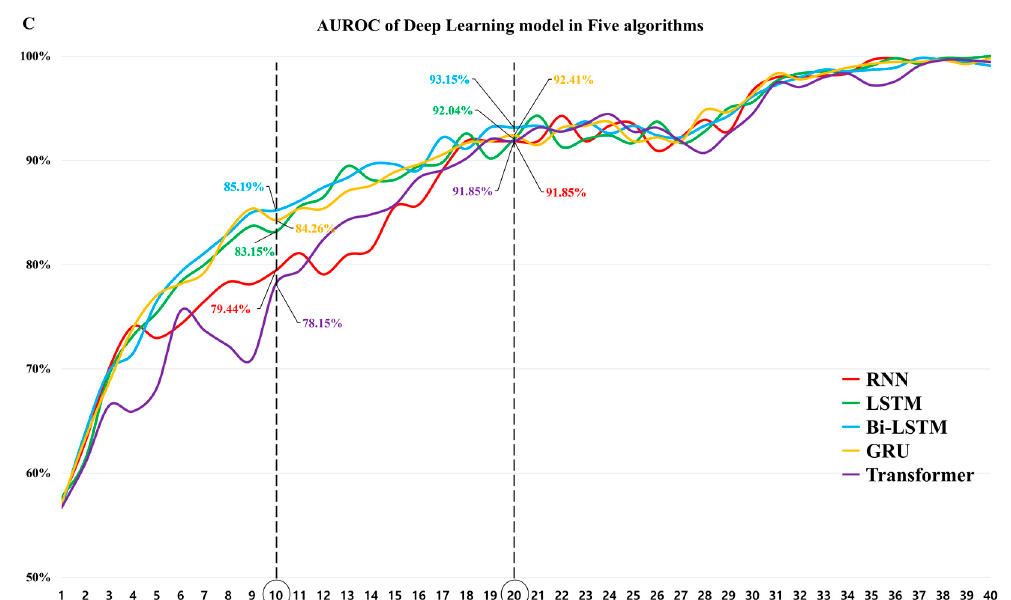
Figure 4. Diagnostic performance of DL models in five different algorithms using the test dataset. ( A ) Sensitivity of DL model in five algorithms. ( B ) Specificity of DL model in five algorithms. ( C ) AUROC of DL model in five algorithms. RNN: recurrent neural network; LSTM: long short-term memory; GRU: gated recurrent unit; Bi-LSTM: bidirectional long short-term memory; AUROC: area under the receiver operating characteristic; DL: deep learning.